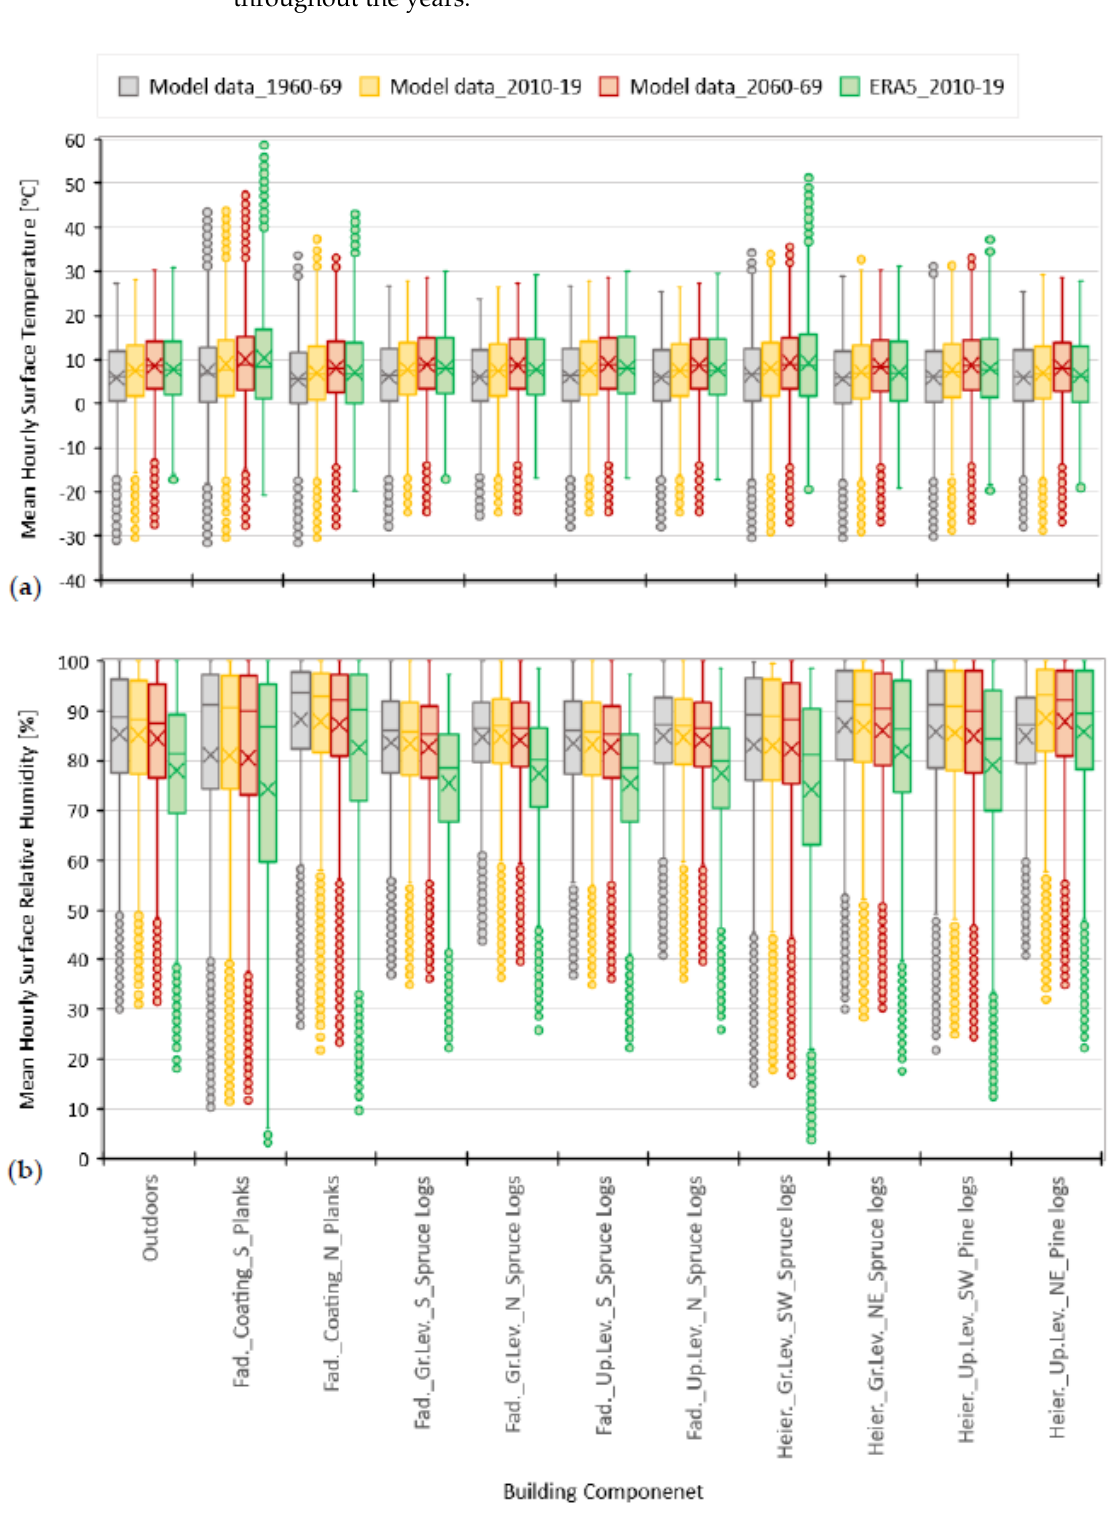
Figure 13. Distribution of ( a ) hourly surface temperature and ( b ) hourly surface relative humidity for the exterior surface of selected building components. In the boxplots the box shows 50% of the data, with median represented as a horizontal bar and the average value highlighted with the ‘x’ symbol. The whisker extends to two standard deviations of the data, and the circles represent the outliers.